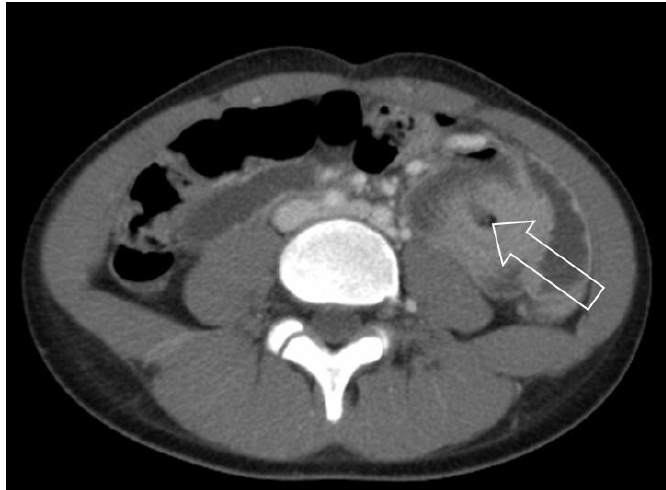
Figure 2. Target sign signifying intussusception. The arrow points to the tail of the bezoar acting as a lead point for the